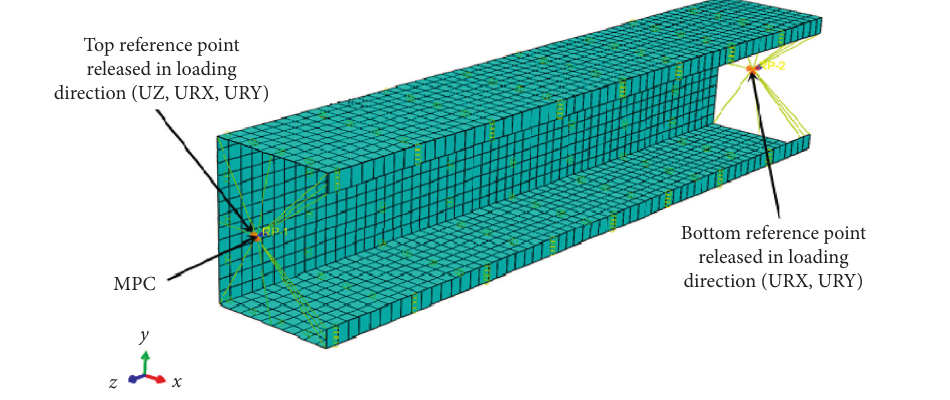
Figure 3: Boundary conditions.